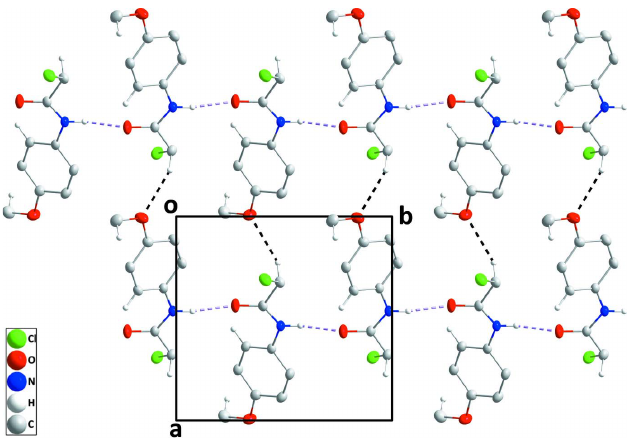
Figure 2 A portion of one layer of the crystal packing viewed along the c -axis direction with N—H (cid:2)(cid:2)(cid:2) O and C—H (cid:2)(cid:2)(cid:2) O hydrogen bonds depicted, respectively, by violet and black dashed lines. Non-interacting hydrogen atoms are omitted for clarity.